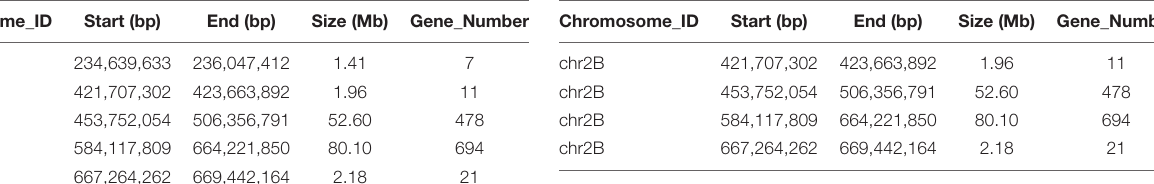
TABLE 1 | The candidate intervals of the R gene PmYD588 and gene numbers in these intervals using SNP index. Chromosome_ID